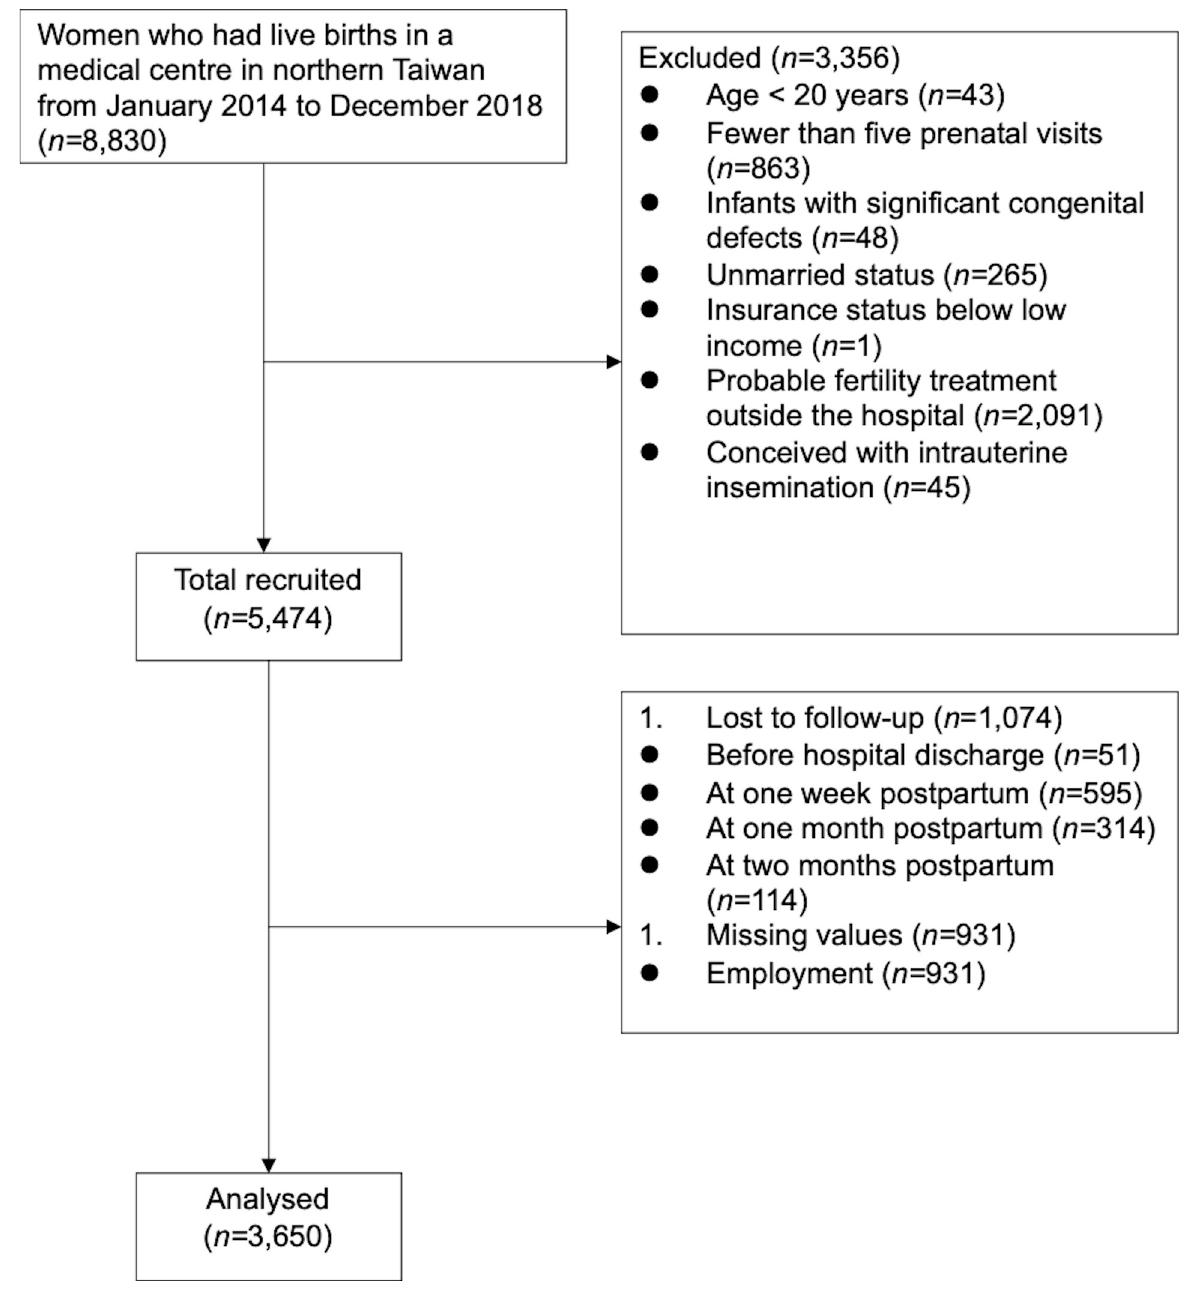
Fig 2. Flowchart of